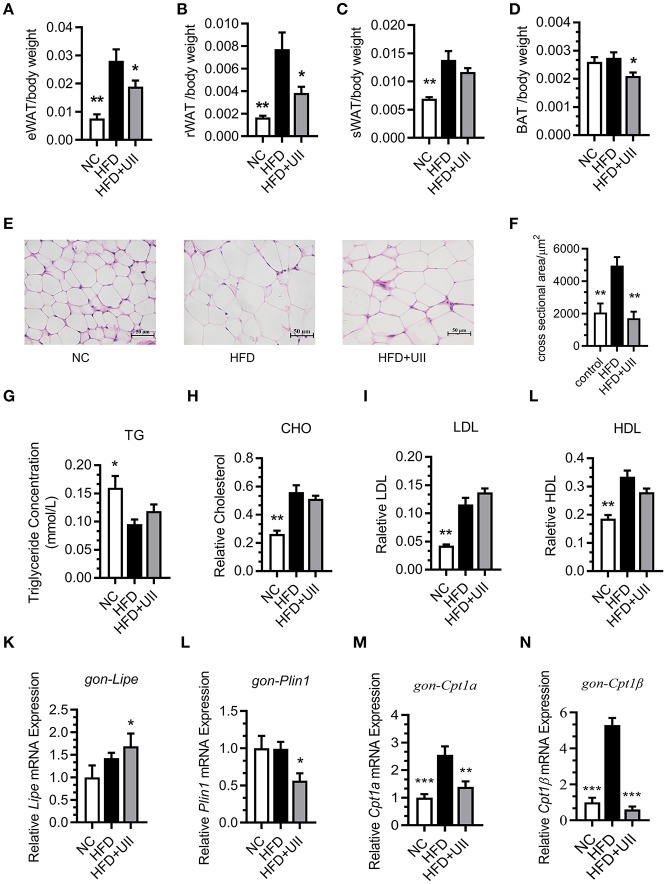
Chronic urotensin-II administration reduced fat tissue weight but had no effect on blood lipid levels. (A–D) Fat mass index of epididymal adipose (eWAT), retroperitoneal adipose (rWAT), subcutaneous white adipose tissue (sWAT), and brown adipose tissue (BAT) of HFD mice treated with uroteinsin-II for 21 days. (E) Representative images (five total images per group) of H&E staining of eWAT. (F) Adipose cell size of eWAT (five total images per group). (G) Blood triglyceride levels. (H) Blood CHO levels. (I) Blood LDL levels. (J) Blood HDL levels. (K–N) Relative mRNA expression levels of genes involved in lipolysis and fatty acid oxidation in eWAT. (K)
Lipe mRNA. (L)
Plin1 mRNA. (M)
Cpt1α mRNA. (N)
Cpt1β mRNA. Scale bars, 50 μm. Data are represented as the means ± SEM, n = 7; biological replicates. Statistical analysis tested by one-way ANOVA with Dunnett's multiple comparisons test analysis. *P < 0.05, **P < 0.01, ***P < 0.001 for compared with HFD control.